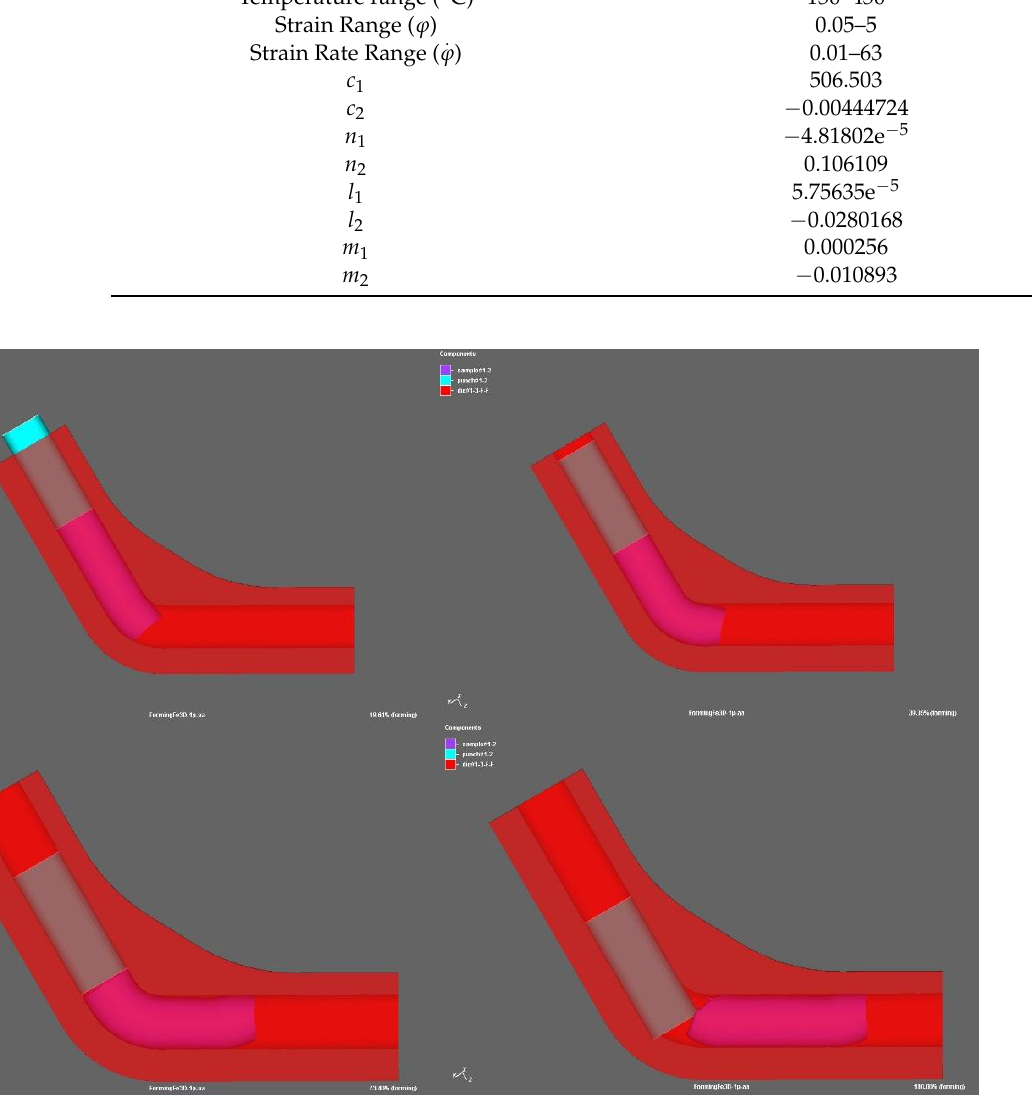
Figure 4. FE simulation stages of the AA2011 aluminum alloy. For multiple passes, from the last step in the previous simulation, geometry data is interpolated in the first step of any new pass. The Bc route has been modeled by the software positioning option, in which the last step sample of each pass was used as